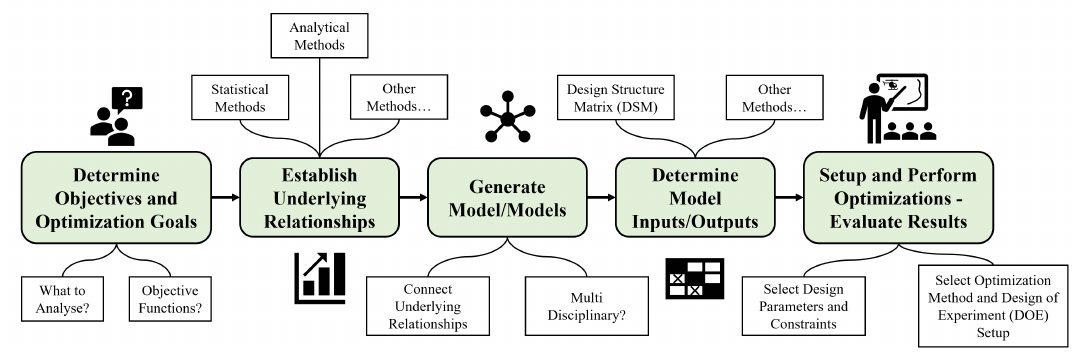
Figure 3. The general method and workflow for creating optimization frameworks for early design